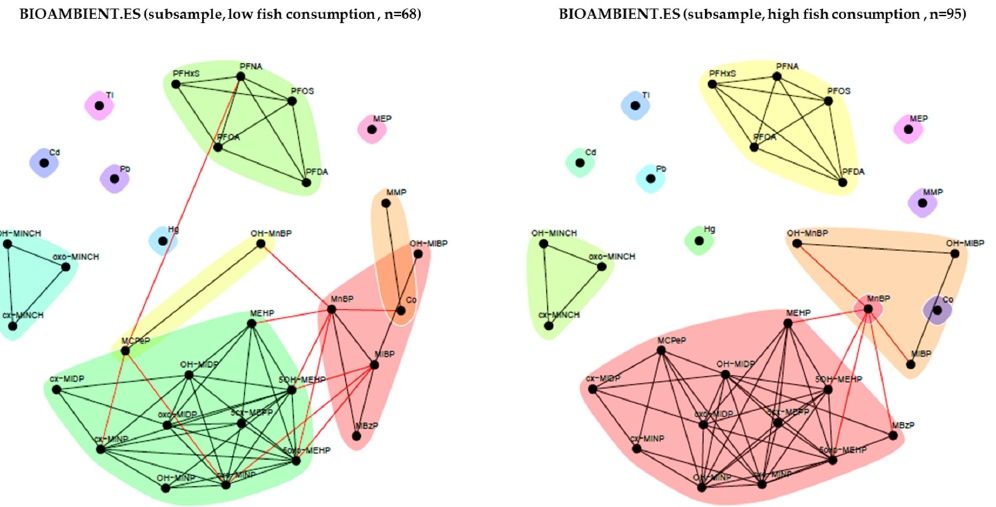
Figure 17. BIOAMBIENT.ES: unweighted network for participants with a low fish consumption (left) and participants with a relatively high fish consumption (right). The data were corrected for sex, age, BMI and smoking status. Low fish consumption is defined as consumption of fish less than 1–3 times per week and high fish consumption is defined as fish consumption of at least 1–3 times per week. Black lines indicate dependency between nodes (biomarkers) within a community; red lines indicate dependency between nodes in different communities.